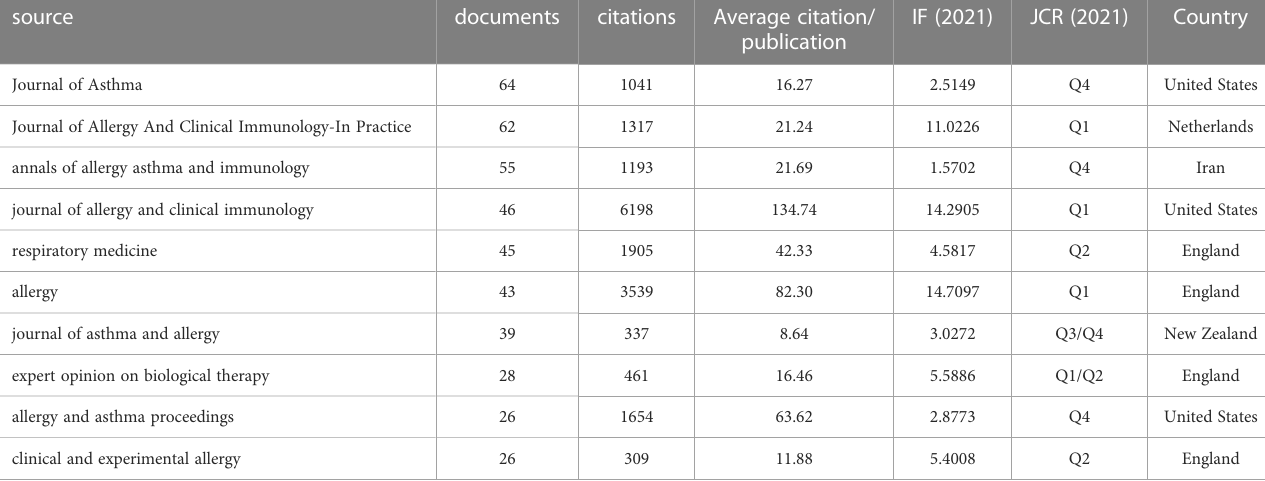
TABLE 1 The top 10 journals with the most